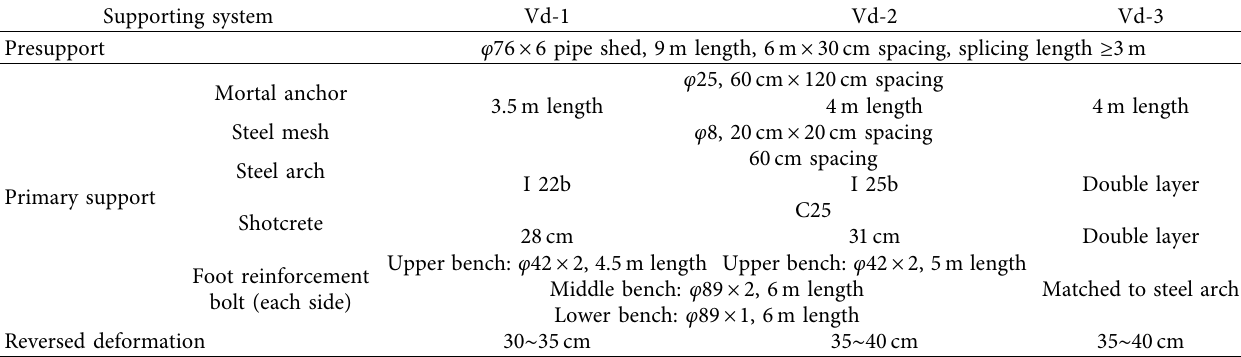
Figure 15: Configuration of foot reinforcement bolts in the double-layer primary lining for grade Vd-3 rock mass. Table 3: Configuration of dynamically adaptive support system in talus-like formations in Tayi